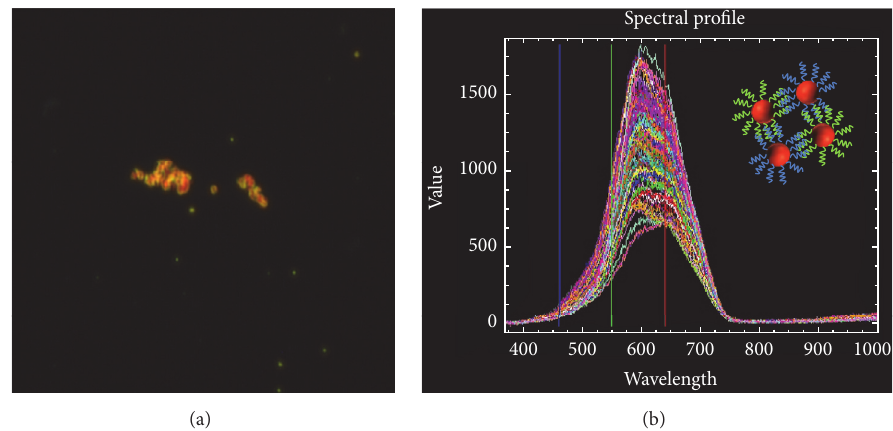
Figure 4: Hyperspectral imaging of hybridized 4nm Au NPs. (a) Digital image and (b) spectra of hybridized 4 nm Au A1 + C1